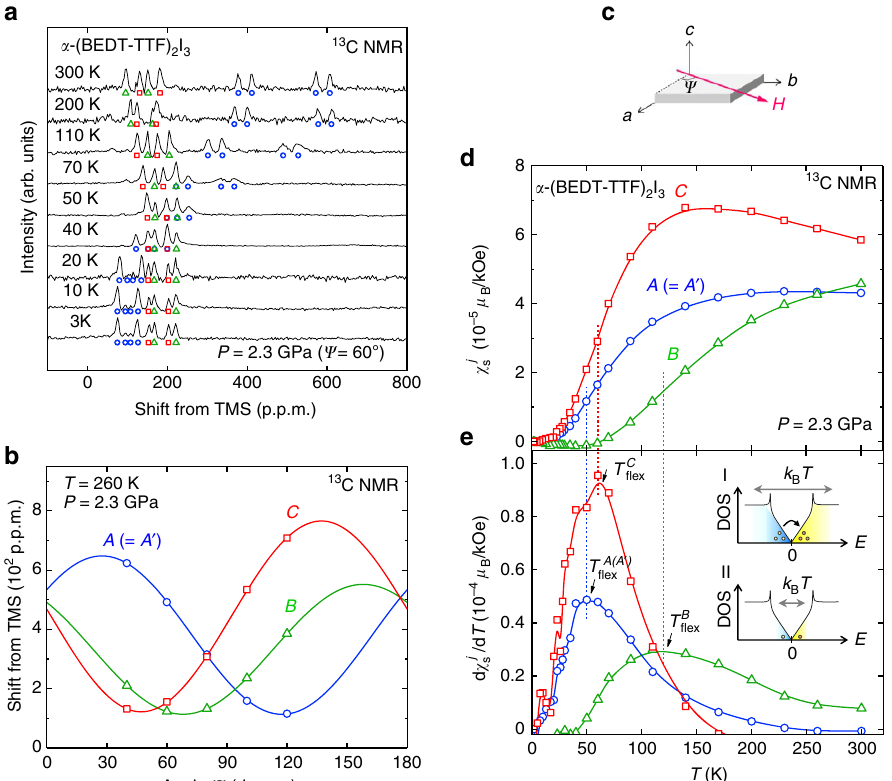
Figure 2 | Site-selective NMR probes anisotropic tilted Dirac cones. ( a ) Temperature, T , dependence of the 13 C-NMR spectra measured under P ¼ 2.3GPa at the magnetic field of H ¼ 6 Tapplied in the crystalline ab -plane (for the direction c ¼ 60 o ). Symbols denote the 13 C lines associated to the three non-equivalent sites in the unit cell: j ¼ A ( ¼ A ’) (circles), B (triangles) and C (squares). ( b ) Field angular dependence of the centre-of-mass positions of the corresponding 13 C lines for each sublattice. Lines indicate the sinusoidal fitting curves. ( c ) Definition of the field-angle c in the ab -plane, measured T ð Þ plotted against T , which are determined from the spectra measured at c ¼ 60 o for the site from the a axis. ( d ) Local electron-spin susceptibility w j s A ( ¼ A ’) and c ¼ 120 o for the site B and C . Lines are the guide to the eyes. ( e ) The T dependence of the first derivative d w j E 50K, T B E 120K and T C E 60 K) is indicated by arrows and vertical dashed lines. Lines stand for the guides to the eyes. Inset: Schematic ( T A flex flex flex illustrations of thermal excitations of electron–hole pairs around the gapless point at E F ( ¼ 0) for high T ( T 4 T j